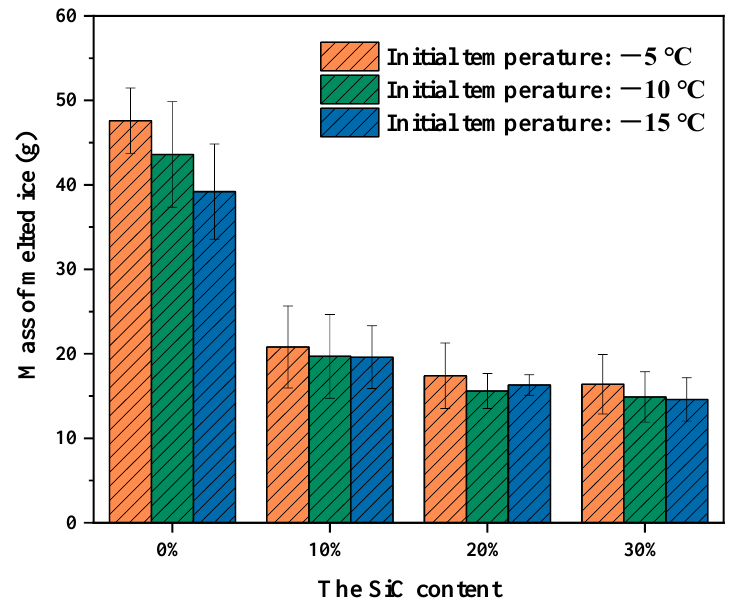
Figure 13. Mass of melted ice of UMLs with different SiC contents.